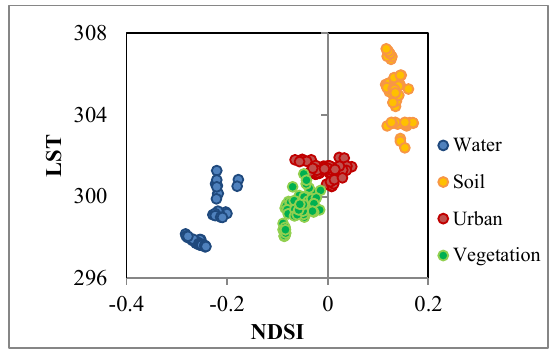
Figure9. LST-NDSI relation with land cover Waterbodies shows very low negative values for NDSI whereas bare soil shows very high positive NDSI values. Urban areas have NDSI values near to zero with positive as well as negative values of NDSI. Vegetation shows negative values of NDSI near to zero. This explains linear relation of LST with NDSI.